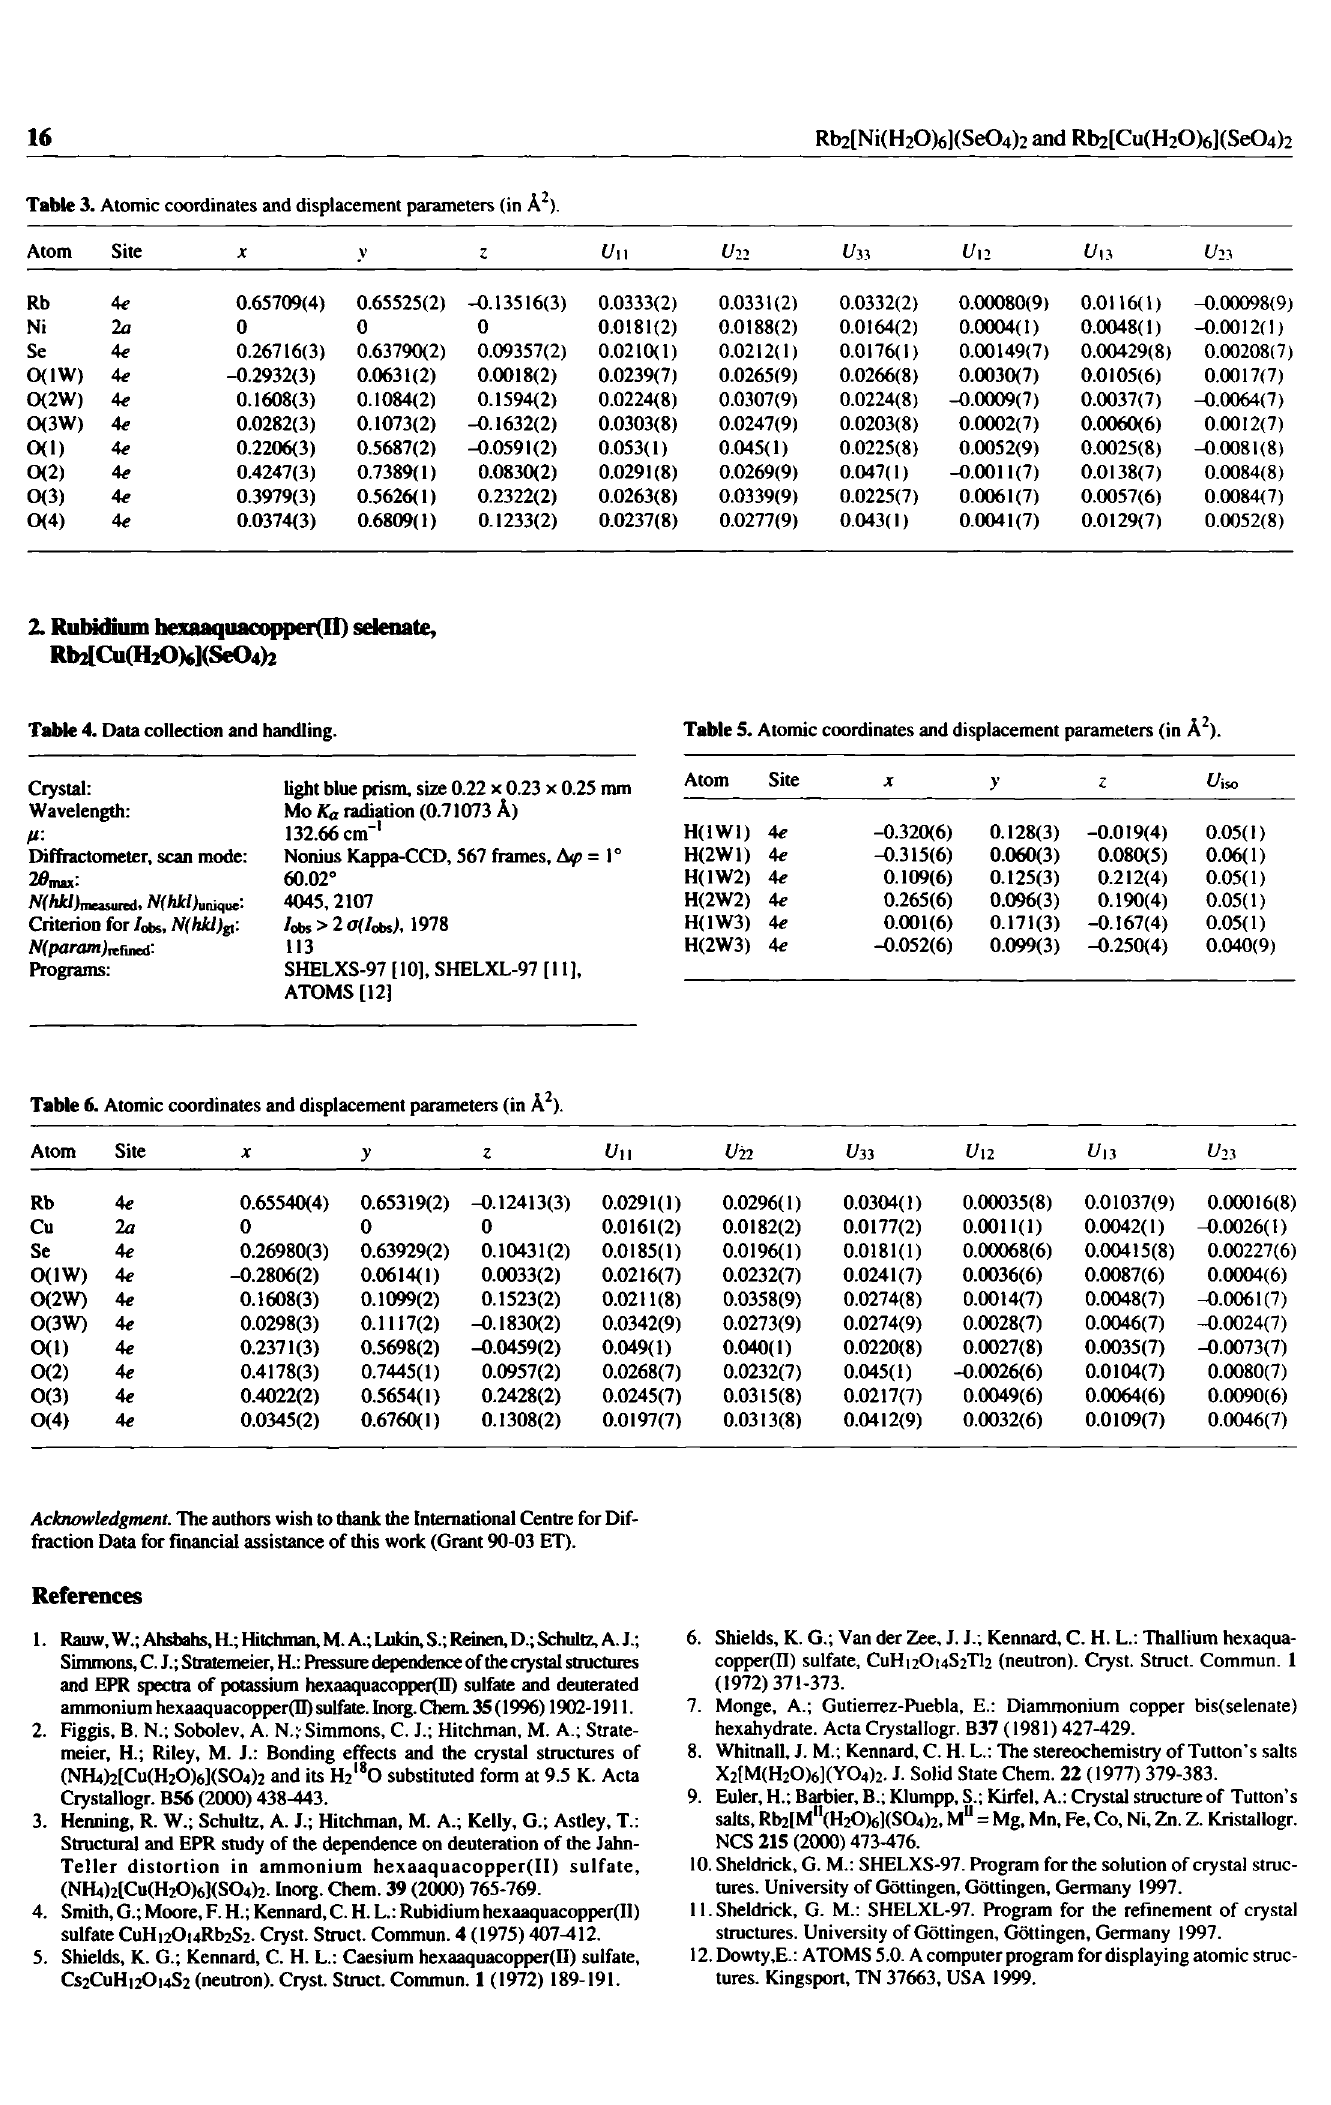
Table 4. Data collection and handling. Table 5. Atomic coordinates and displacement parameters (in Â 2 ).